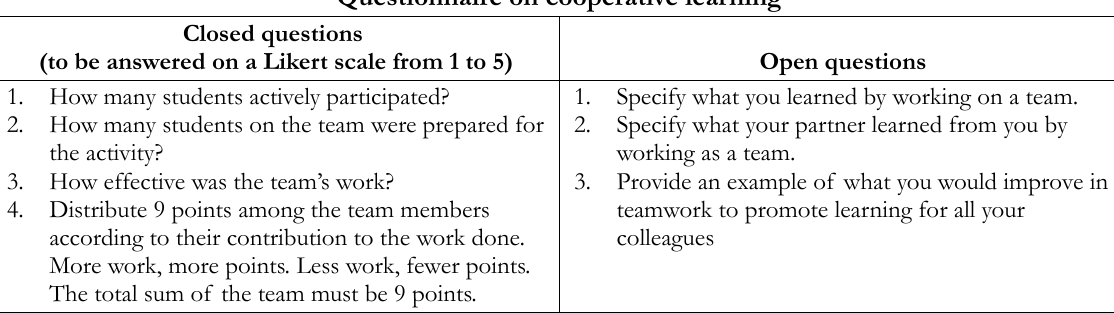
Table 5. List of closed and open questions of the student satisfaction questionnaire administered within the